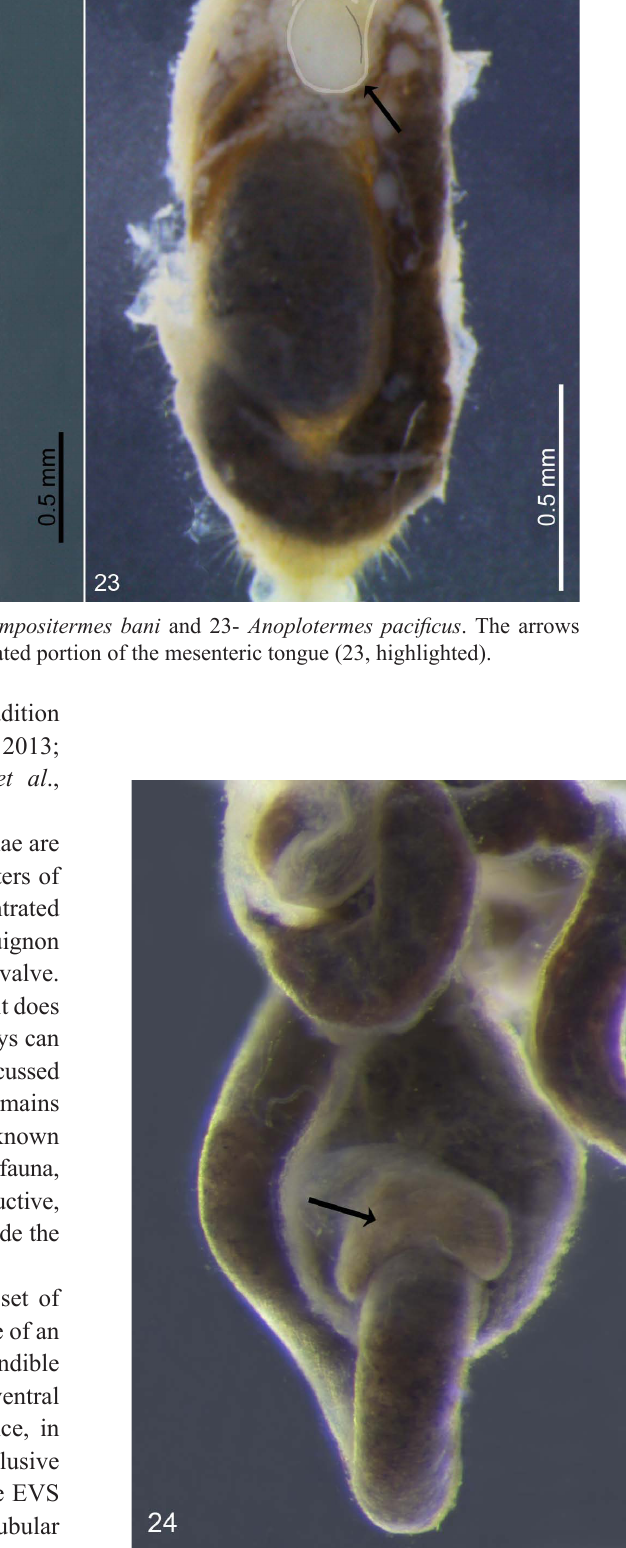
Fig 24. Ruptitermes maraca , right view of the gut (arrow: trilobate enteric-valve seating-